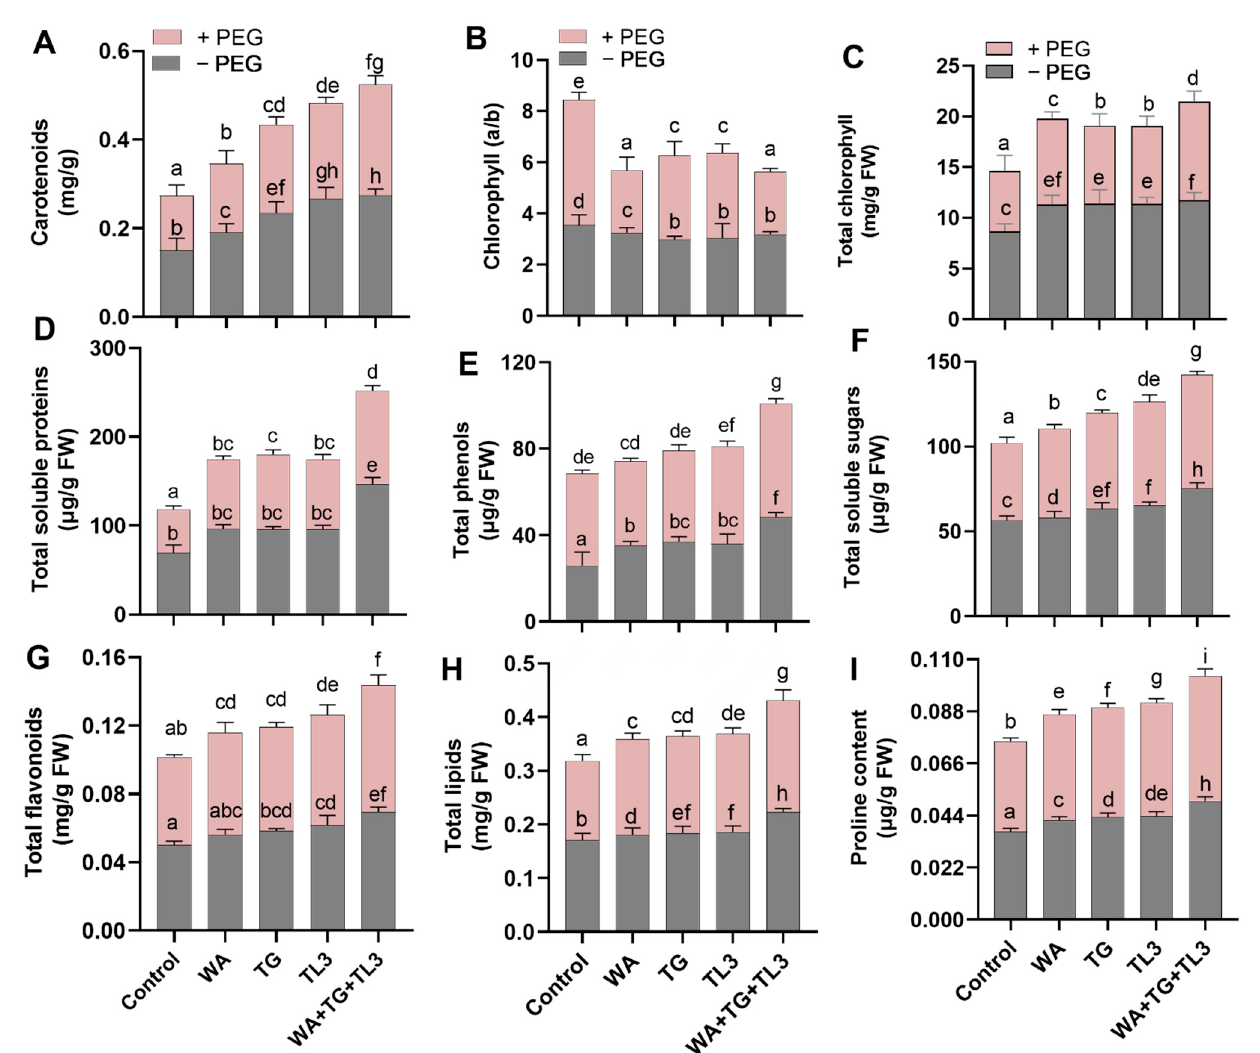
Figure 6. Effect of WA, TG, and TL3 inoculation on M. oleifera growth promoting metabolites. ( A ) Carotenoids, ( B ) chlorophyll a/b ratio, ( C ) total chlorophyll, ( D ) total soluble proteins, ( E ) total phenols, ( F ) total soluble sugars, ( G ) total flavonoids, ( H ) total lipids, and ( I ) proline content. Quantitative data represent means ± SE of three independent biological replicates presented with various letters showing differences at the significance level of p ≤ 0.05 using Duncan’s multiple range test (DMRT).